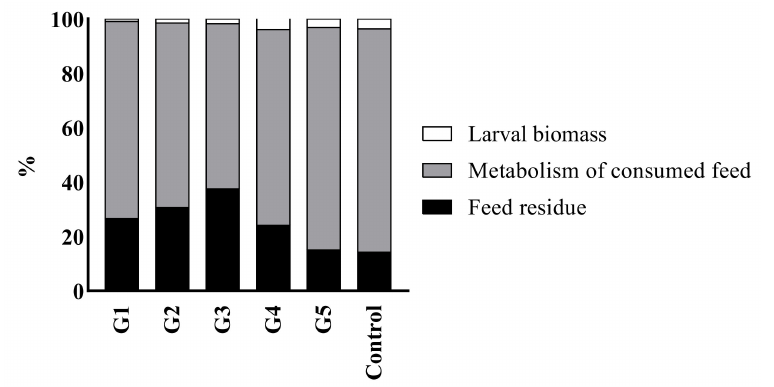
Figure 3. Proportion of feed converted into larval biomass, feed used for metabolism, and feed residue for each ratio of blended sewage sludge employed for BSFL rearing.